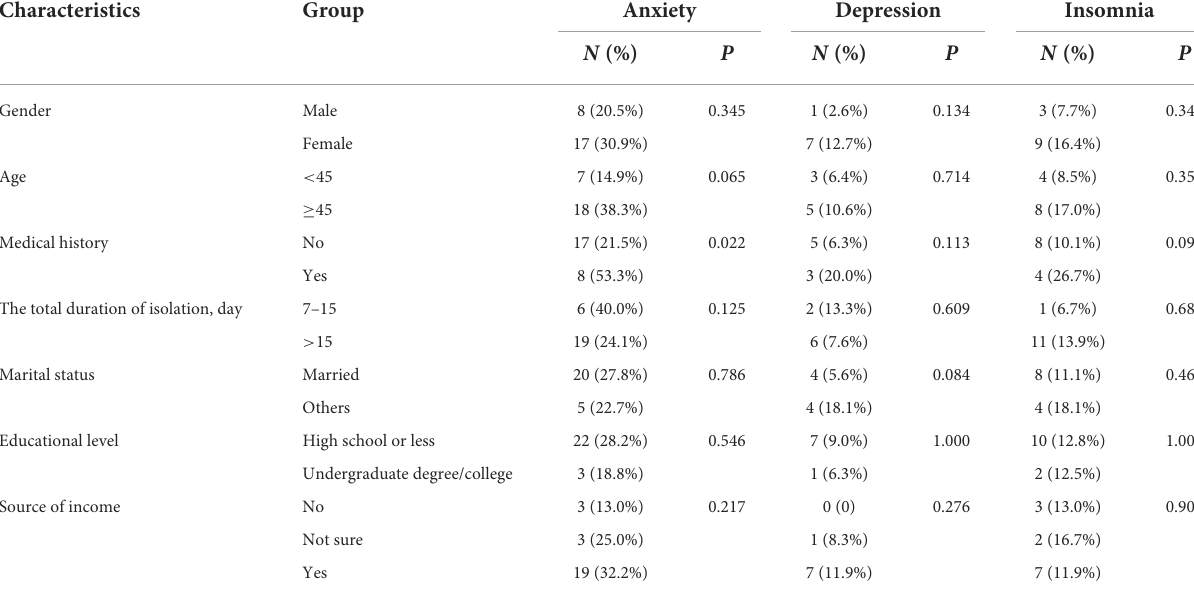
TABLE 2 The demographic distribution of psychological symptoms among initially confirmed COVID-19 patients ( N = 94). Characteristics Group